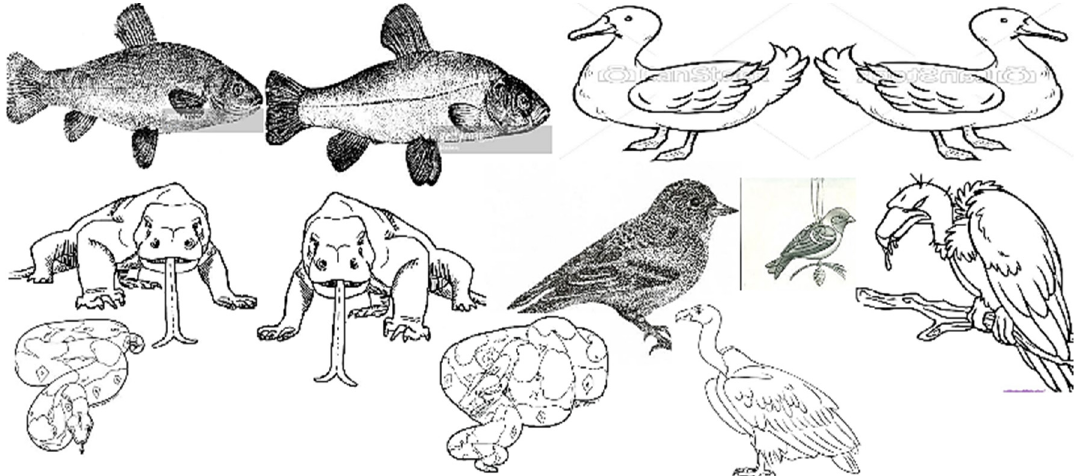
Figure 5. Randomly-selected image pairs from ImageNet-sketched dataset [42].